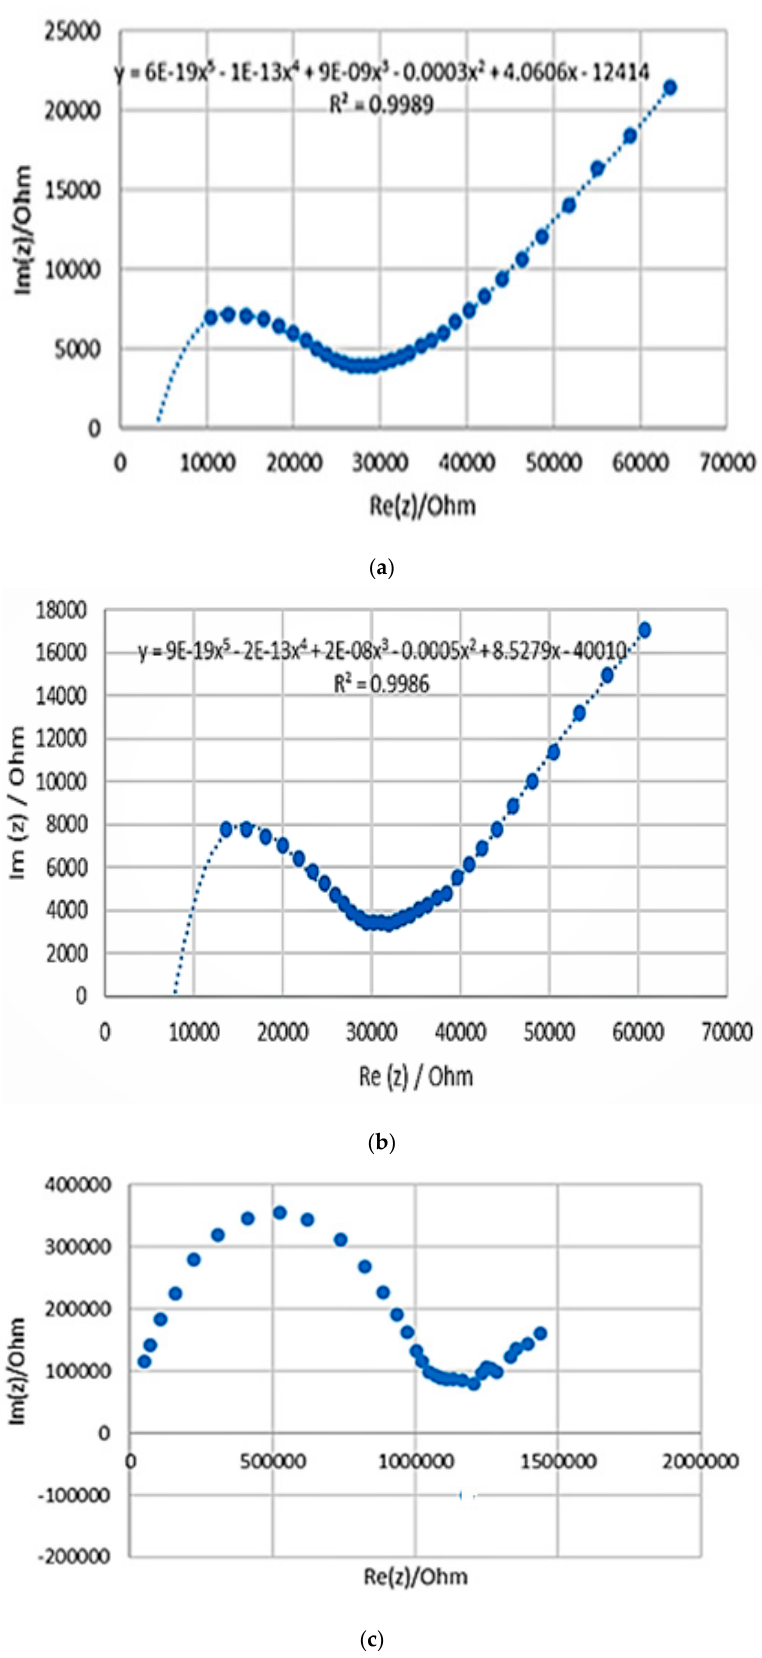
Figure 2. Nyquist plots for various samples: ( a – c ) shown are for samples 1, 2, and 3, respectively. For compositions, refer to Table 1.